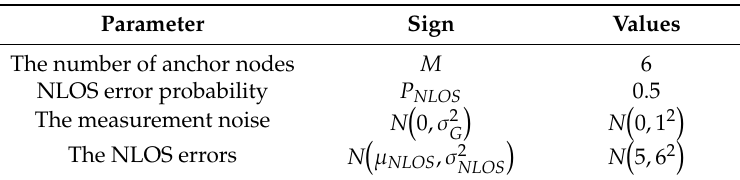
Table 1. Gaussian distribution parameter.